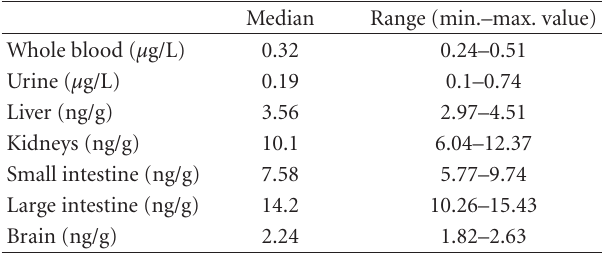
Table 1: Total mercury in whole blood, urine, liver, kidneys, small intestine, large intestine, and brain of the control